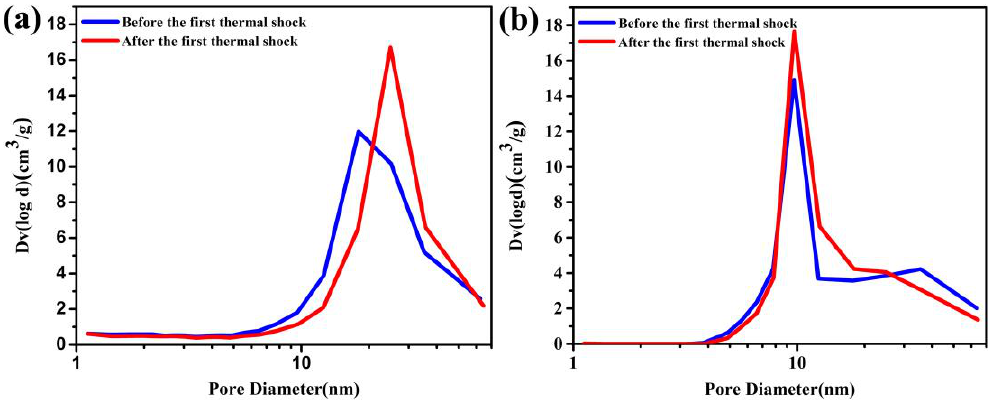
Figure 5. ( a ) Pore size distribution of the CO 2 -SPD aerogels before and after the first thermal shock; ( b ) The ethanol-SPD aerogels before and after the first thermal shock. Table 1. The specific surface area and pore structure parameters of CO 2 -SPD aerogels before ( a ) and after ( b ) the first thermal shock, and ethanol-SPD aerogels before ( c ) and after ( d ) the first thermal shock. Here the aerogels used have been treated by removing the glass fibers.